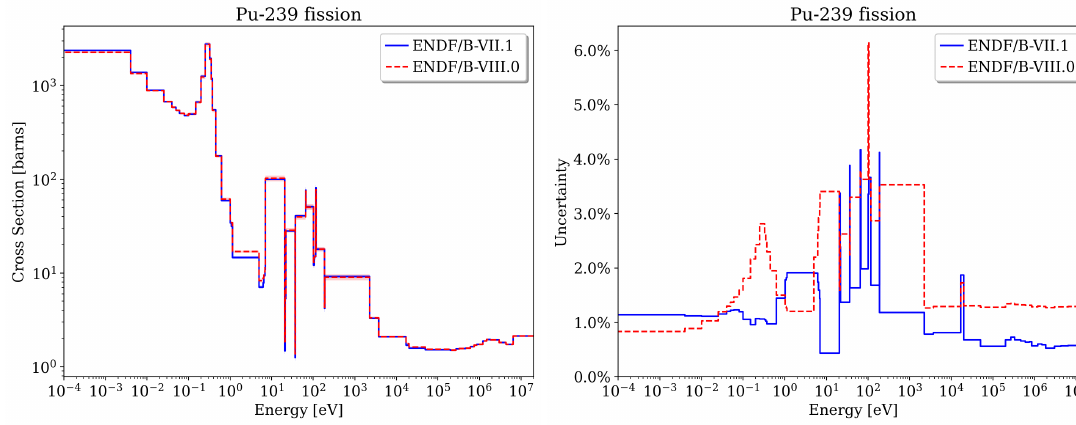
Figure A8. 239 Pu fission nominal data and